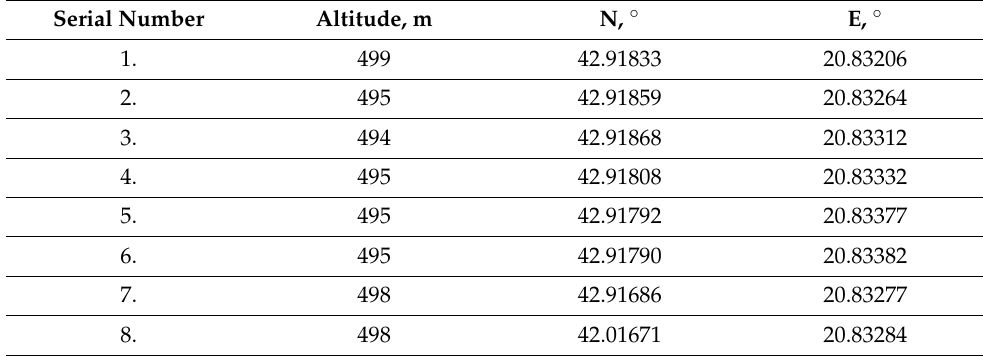
Table 1. Altitude with northern (N) and eastern (E) geographical location.